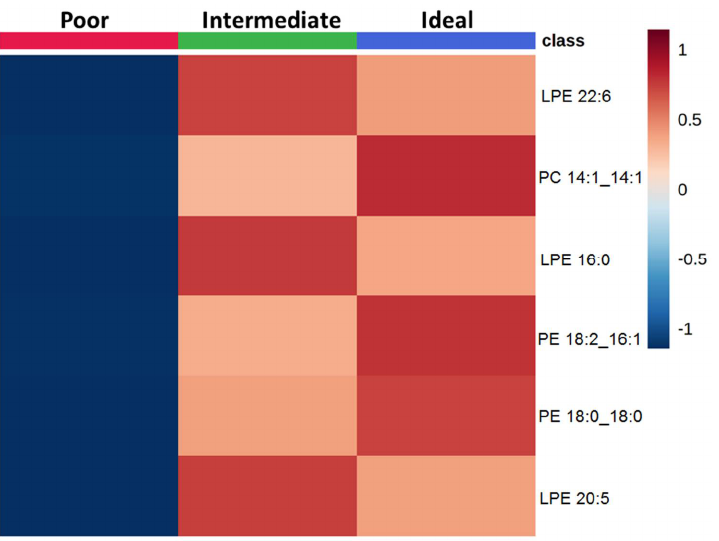
Figure 1. Comparison of lipid species across categories of smoking status. The heatmap shows the average concentrations of important lipid features identified by the ANOVA analysis and grouped by categories of smoking status.